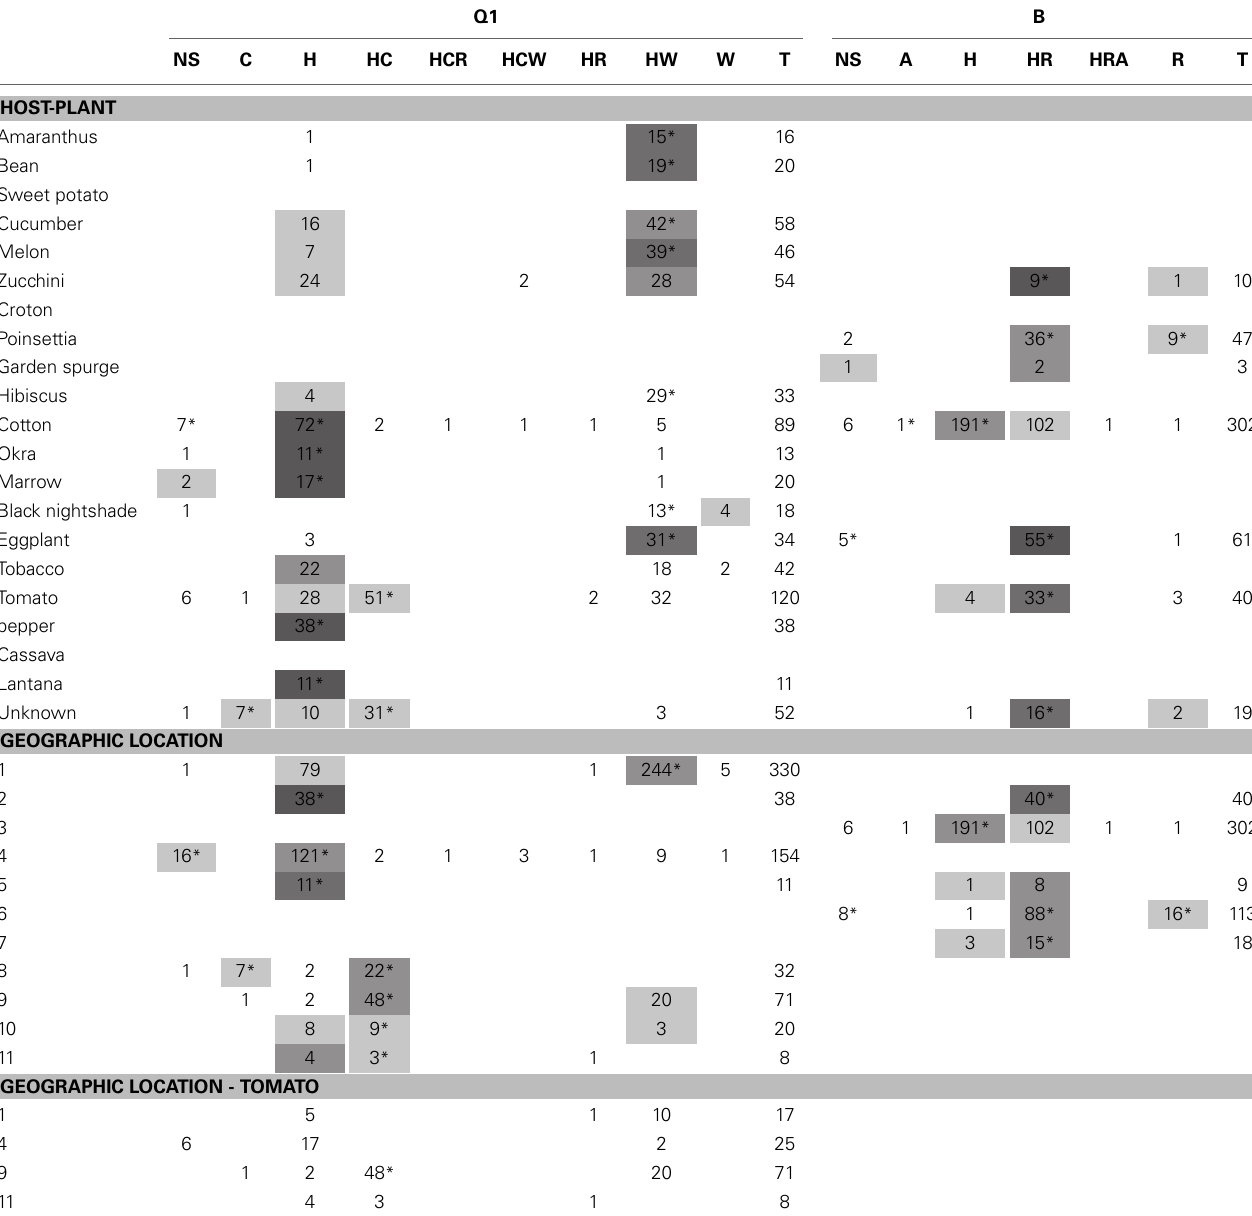
Table 1 | Distribution pattern of biotype-specific facultative endosymbiont combinations (FECs) across collection sites and